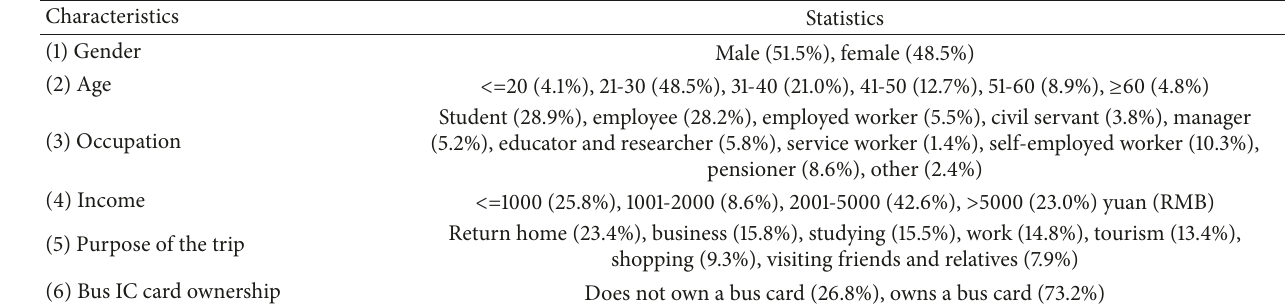
Table 2: Socioeconomic attributes.